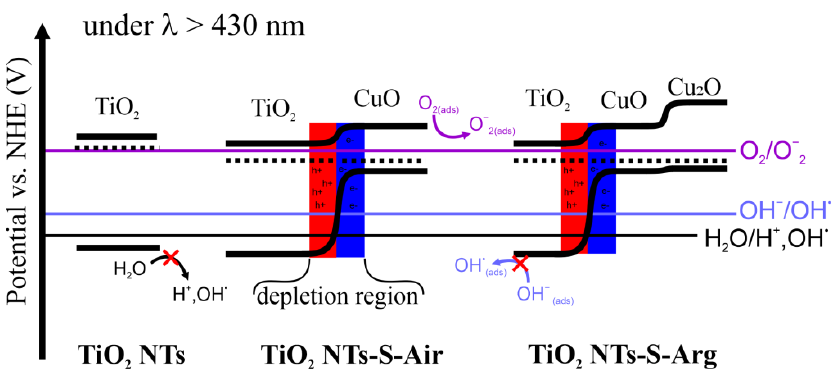
Figure 10. Energy band bending model for TiO 2 NTs/Cu x O composites.